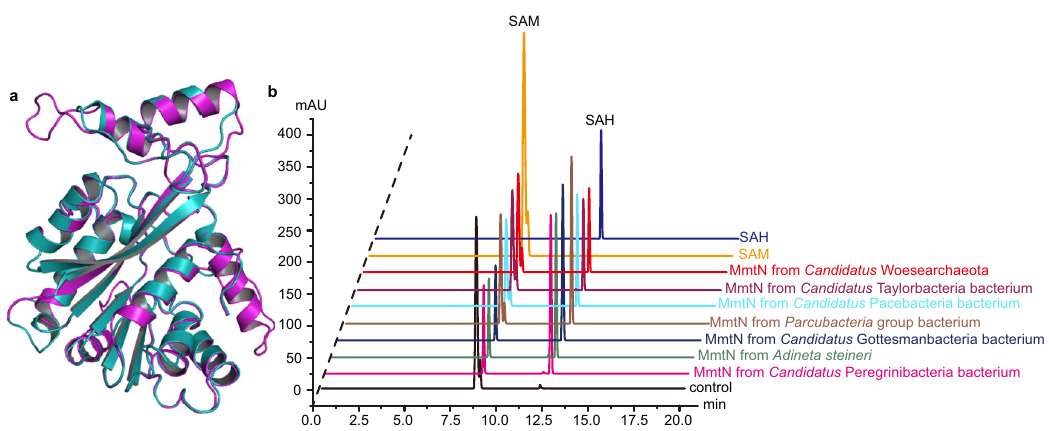
Fig. 8 Characterization and predicted structural analyses of Group II MmtN from Candidatus Woesearchaeota, Adineta steineri , and CPR bacteria. a Structural alignment of MmtN from R. indicus B108 and Candidatus Woesearchaeota. The structure of MmtN from R. indicus B108 is colored in magenta and MmtN from Candidatus Woesearchaeota in cyan. The structure of MmtN from Candidatus Woesearchaeota was obtained using the SWISS-MODEL server (https://swissmodel.expasy.org/). b Detection of Met S -methylation activity of recombinant Group II MmtN enzymes from Candidatus Woesearchaeota, CPR bacteria and the animalcule A. steineri via the intensity of absorbance of SAM/SAH on HPLC (260 nm). The reaction system without enzymes was used as control. The data shown are representatives of triplicate experiments. Source data are provided as a Source Data fi